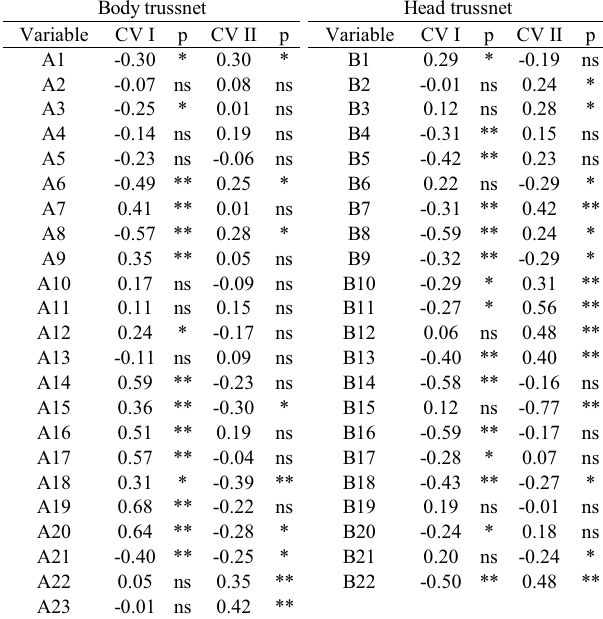
Table 1. Loadings of variables on the first and second size- free canonical variates for separate analyses of lateral and dorsal trussnets in Platydoras armatulus (n=32), P. brachylecis , new species (n=22), and Platydoras sp. Tocantins/Xingu (n=13). ** = probability (p) < 0.01, * 0.01 < p < 0.05, ns = not